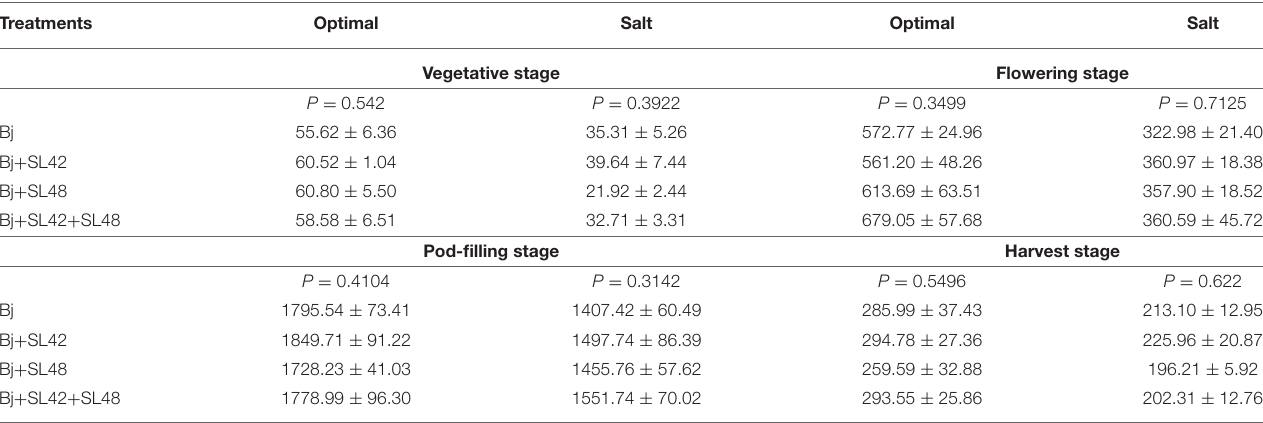
TABLE 2 | Total Nitrogen assimilation in shoot and root tissues of soybean through the developmental stages. Treatments Optimal Salt Optimal Salt Vegetative stage Flowering